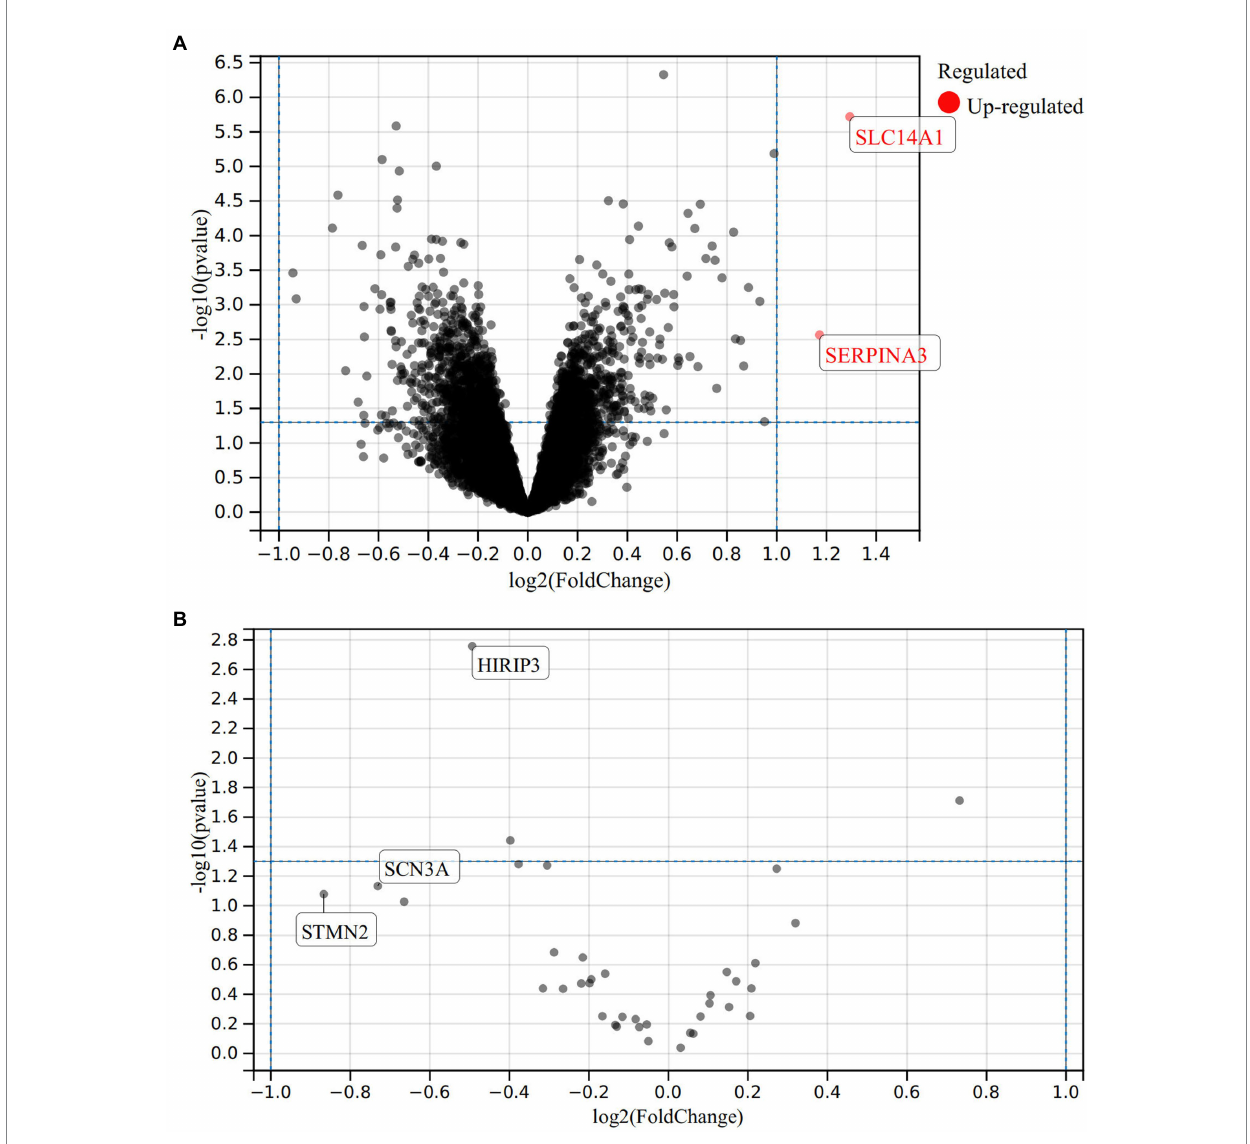
FIGURE 1 Differentially expressed genes for alcohol addiction in the GSE44456 dataset, bounded by p < 0.05, with red dots representing upregulated genes (A) ; Differentially expressed genes associated with smoking addiction in the GSE20568 dataset (B)